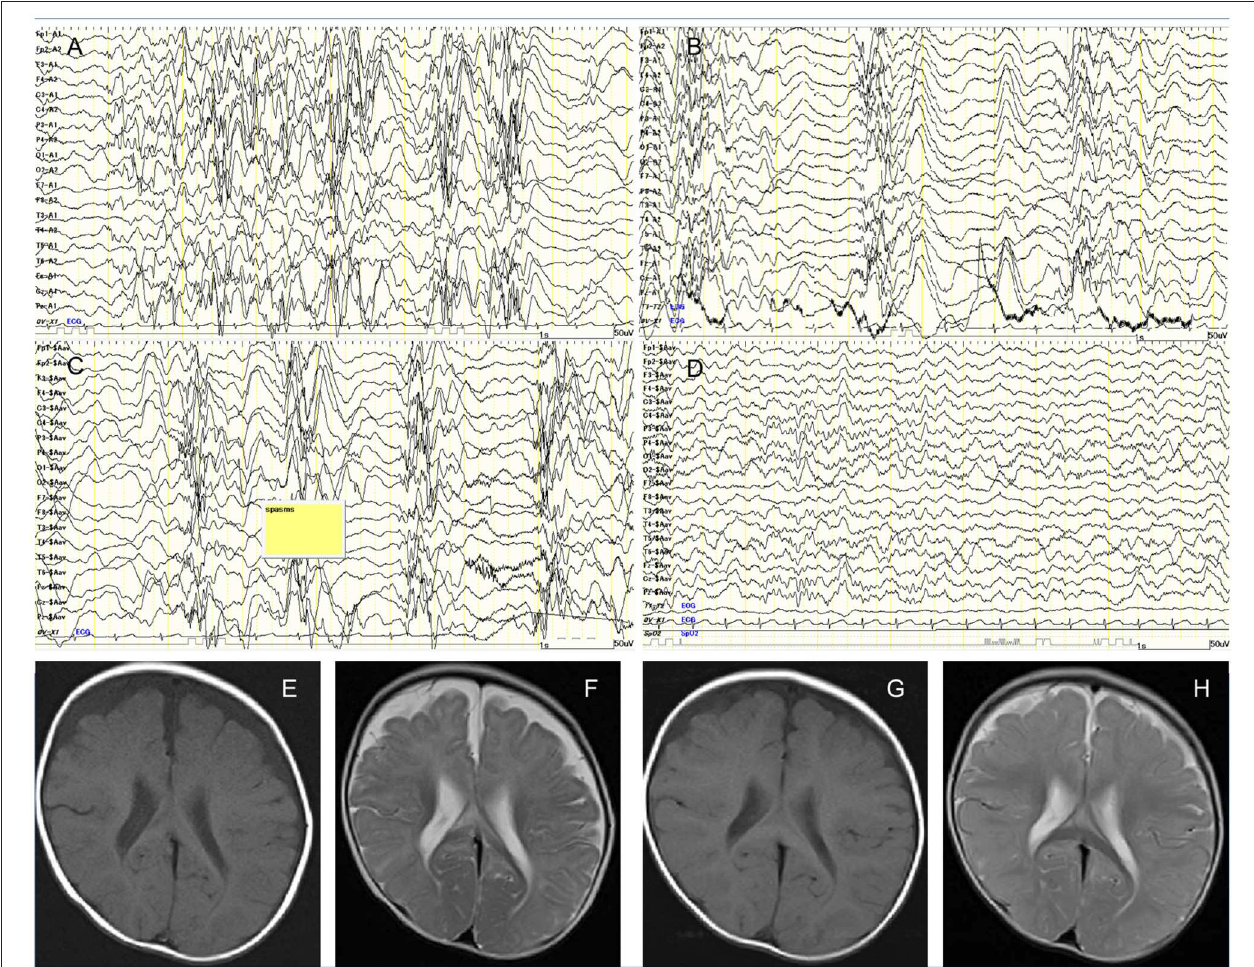
FIGURE 1 | (A) Interictal awake electroencephalography at 7 months showing the characteristic random high-voltage slow waves with spikes and polyspikes activity. (B) Fragmentation of the hypsarrhythmic activity is noticed during sleep recording. (C) Ictal EEG recording showing a cluster of epileptic spasms with high amplitude slow wave at each spasm. (D) Sleep recording showed normalization of background EEG observed 2 months after treatment. (E) Axial T1-weighted image. (F) Axial T2-weighted image of cranial MRI before initiation of adrenocorticotropic hormone therapy at 7 months of age showing cerebral atrophy with frontal predominance and delay in myelination. Follow-up imaging after vitamin B12 supplementation at 14 months of age documenting improved delayed myelination and cerebral atrophy. (G) Axial T1-weighted image. (H) Axial T2-weighted